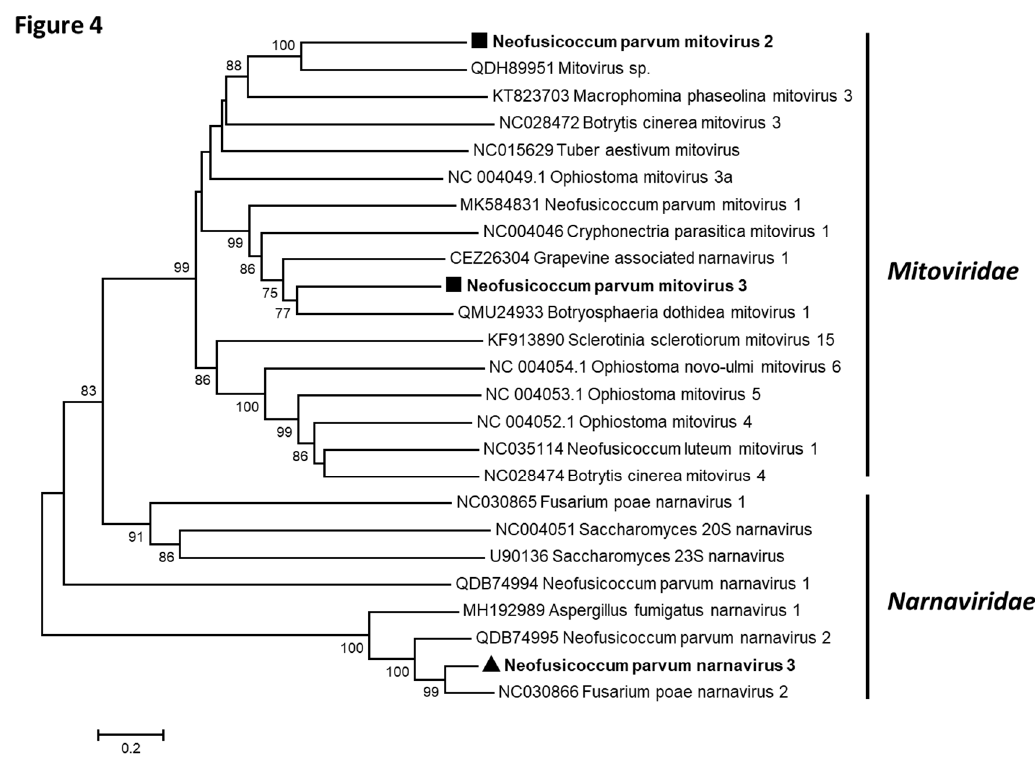
Figure 4. Unrooted phylogenetic tree reconstructed from the alignment of the amino acid sequences of the RdRp of Narnaviridae and Mitoviridae representative members. The tree was constructed by the neighbor-joining method and the statistical significance of branches was evaluated by bootstrap analysis (1000 replicates). Only bootstrap values above 70% are indicated. The scale bar represents 20% amino acid divergence. Neofusicoccum parvum mitovirus 2 and 3 are in bold and indicated by black squares, and neofusicoccum parvum narnavirus 3 is in bold and indicated by a black triangle. The families to which belong the species are indicated in the right of the